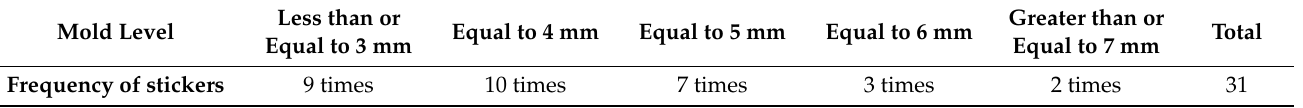
Table 7. Relationship between level fluctuation before sticking and number of stickers.